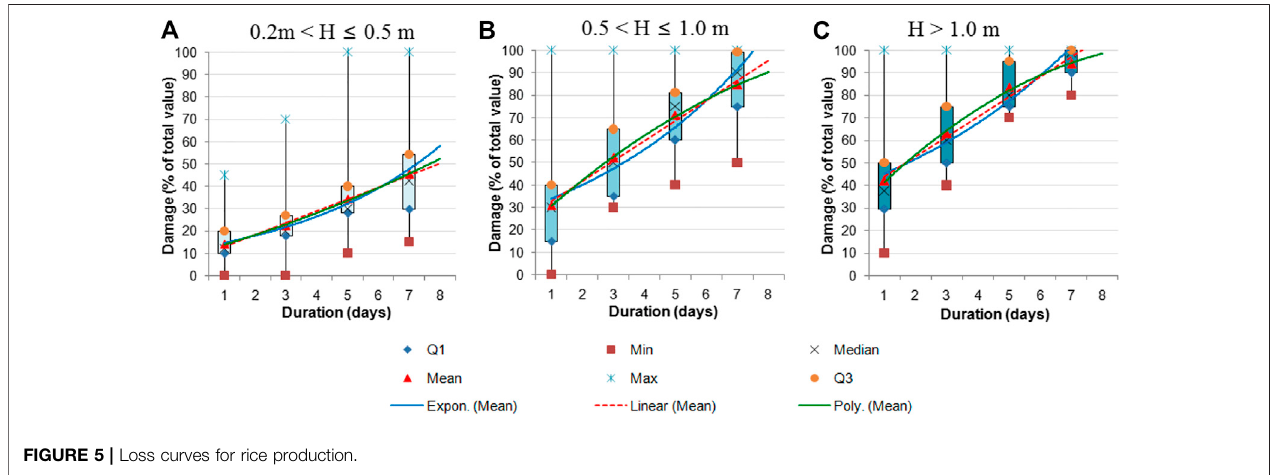
FIGURE 5 | Loss curves for rice production.